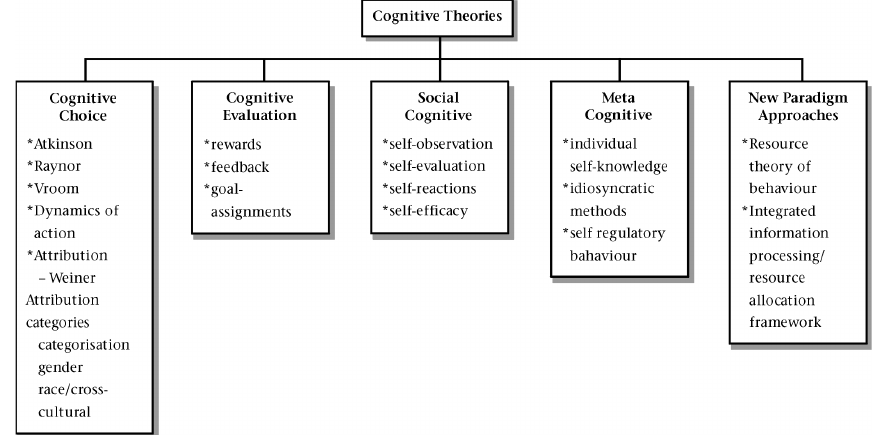
Figure 2: Cognitive